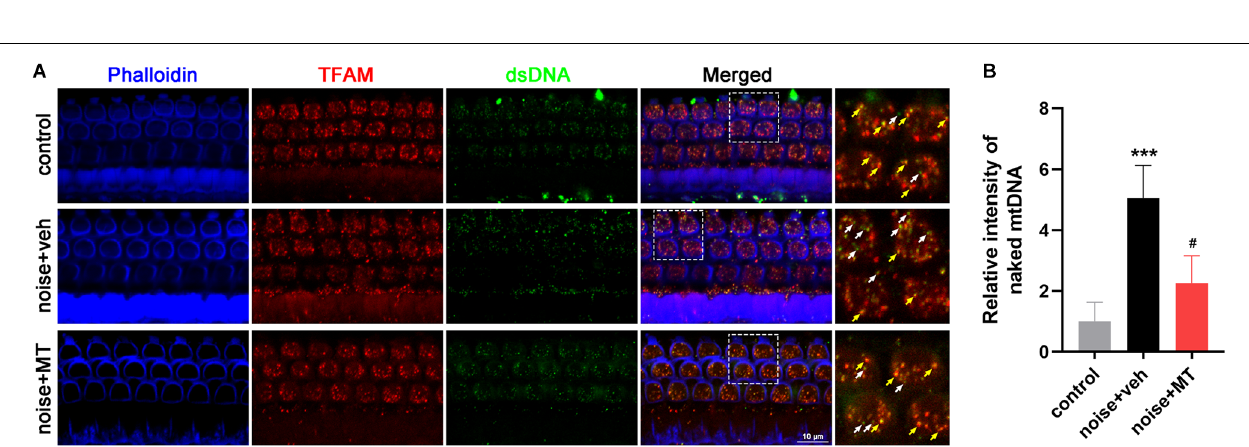
FIGURE 7 | MT treatment mitigated noise-induced downregulation of TFAM and SOD2 independent of the PGC-1 α /NRF-1/TFAM pathway. (A,B) Immunoblotting of the PGC-1 α , NRF-1, TFAM, SOD2, Bax, and ACTB protein in the cochlea 1 h after the noise exposure. (C–G) Quantification analysis of the optical density values of the immunoblot bands normalized by using ACTB as the internal control. Data are presented as means ± SD, n = 4 for each group, * p < 0.05 vs. control group, ** p < 0.01 vs. control group, *** p < 0.001 vs. control group, # p < 0.05 vs. vehicle-treated group.